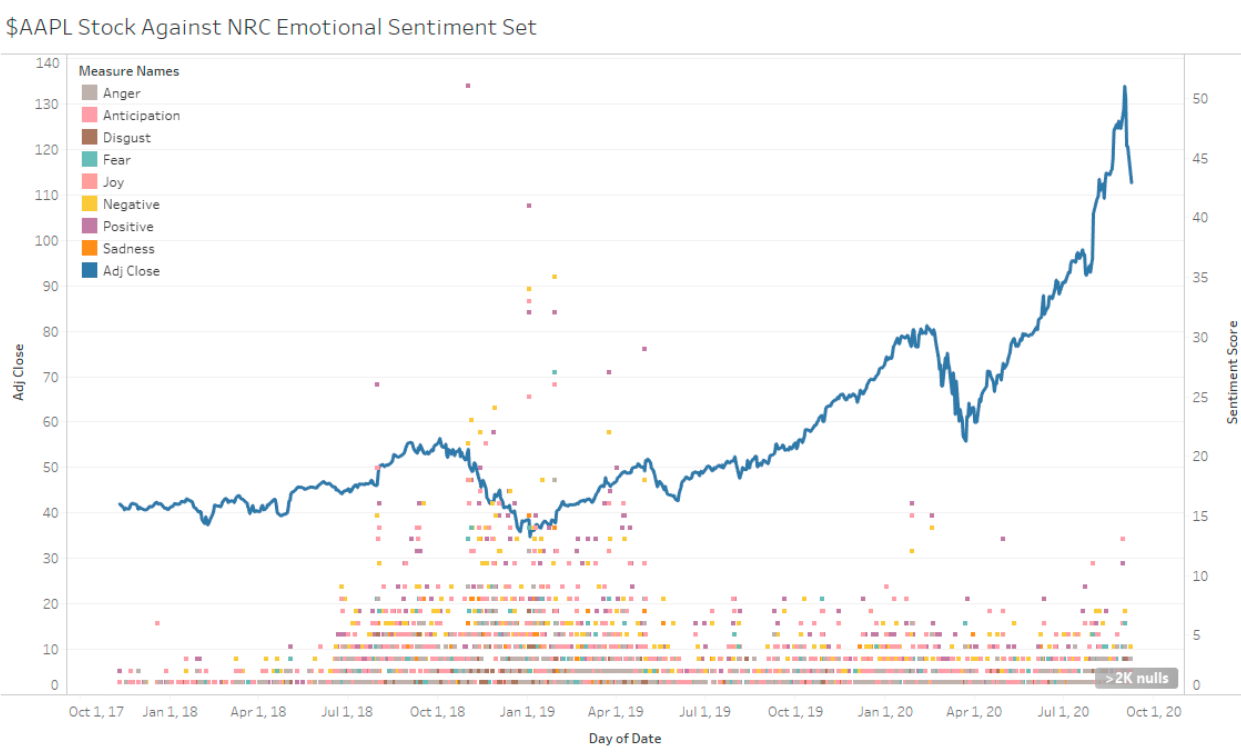
Figure 10. AAPL Stock Against NRC Sentiment.